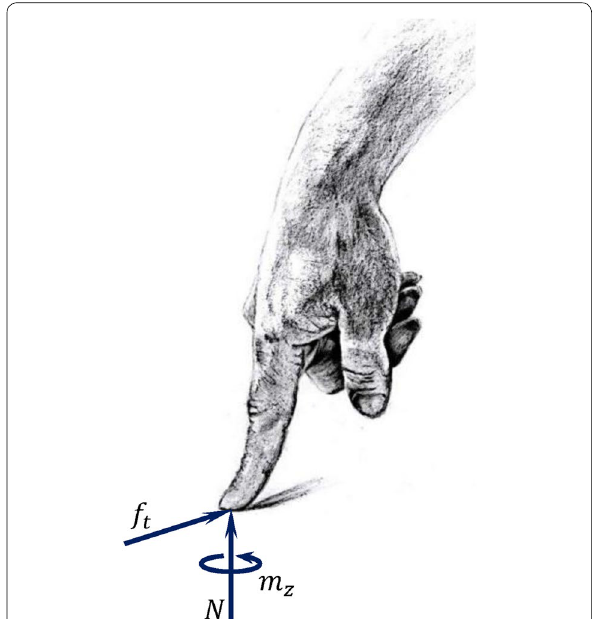
Fig. 1 Normal force, frictional tangential force, and frictional moment in the contact interface of human soft